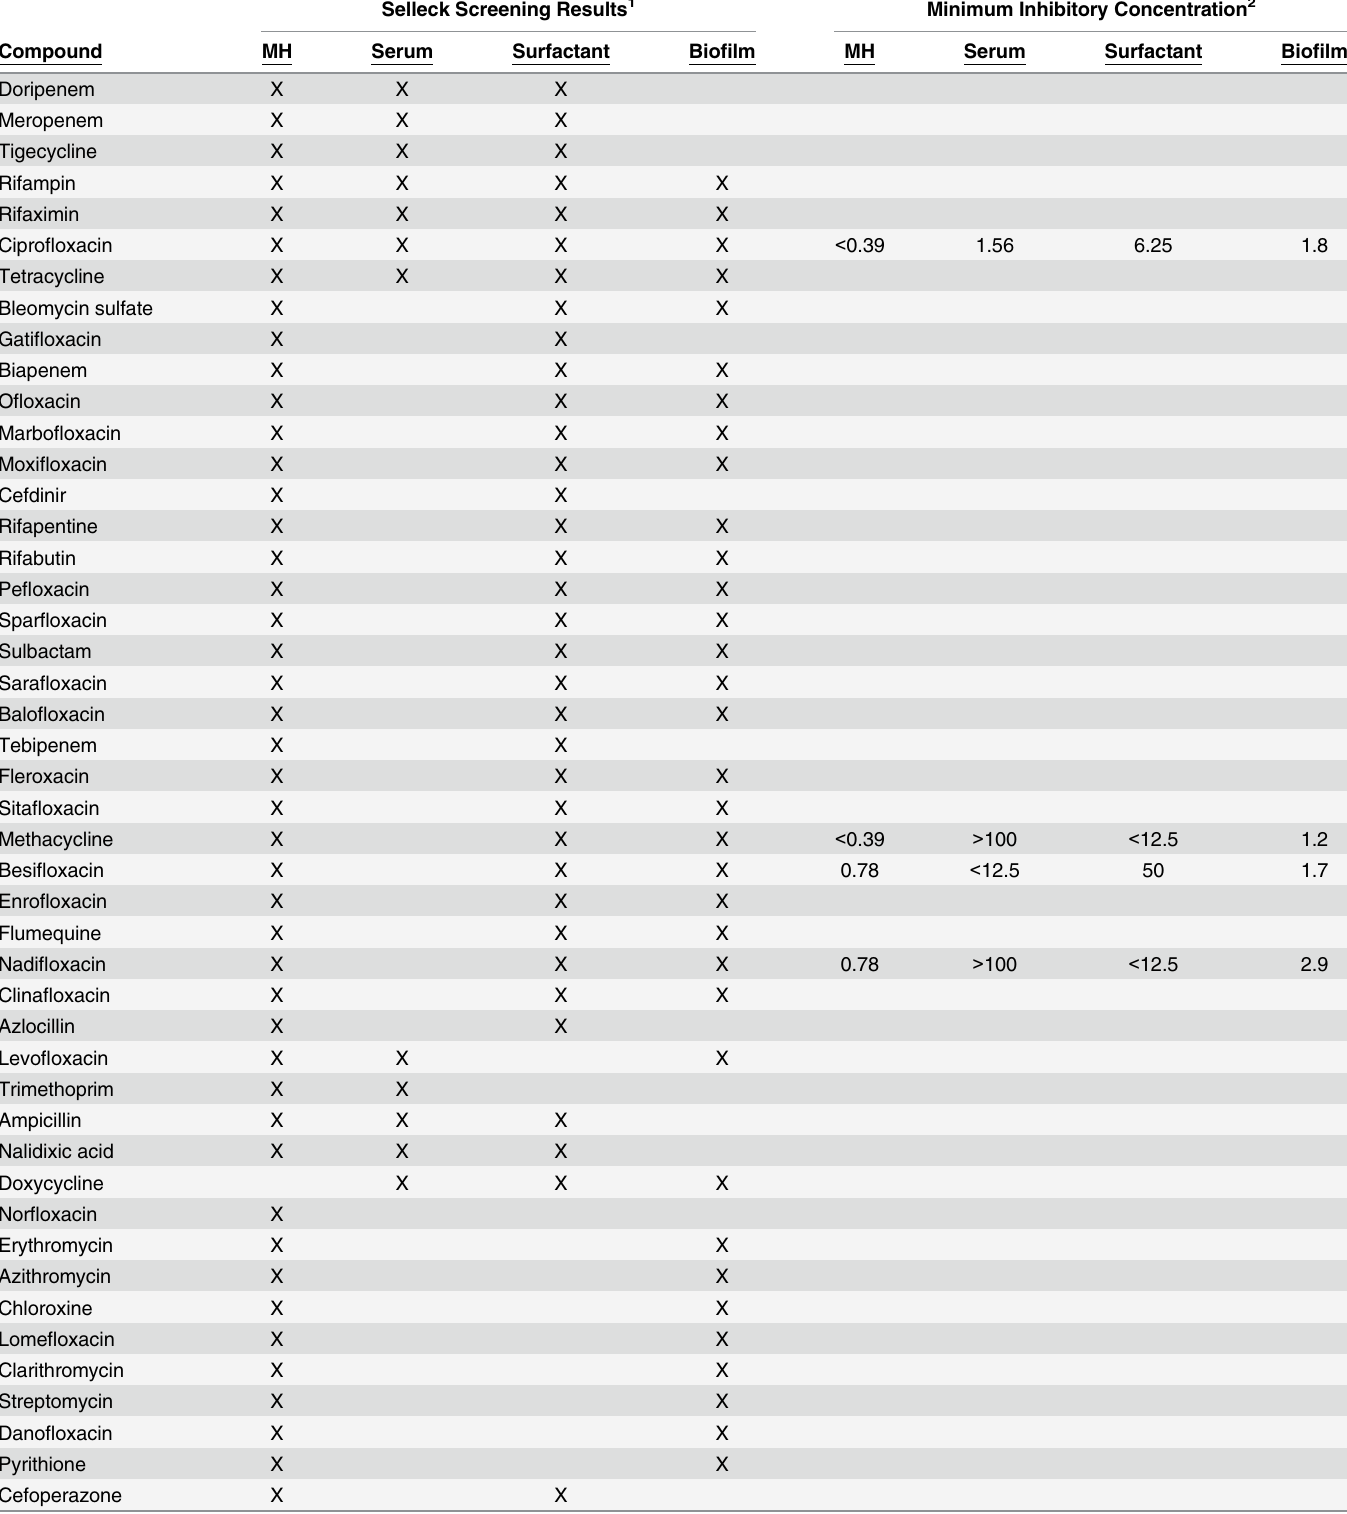
Table 3. Selleck library antibiotic